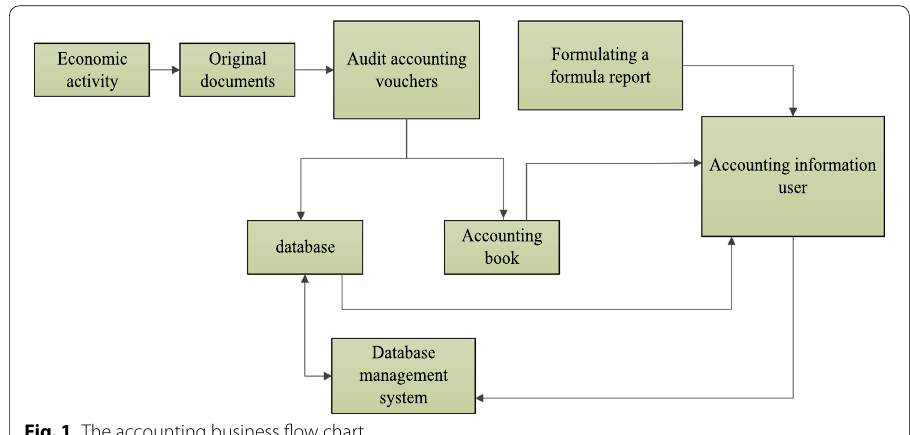
Fig. 1 The accounting business flow